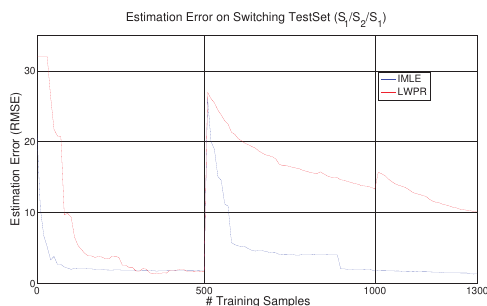
Figure 16. RMSE of the forward kinematic estimation during motor babbling with Kobian, both without and with the tool. Motor babbling is